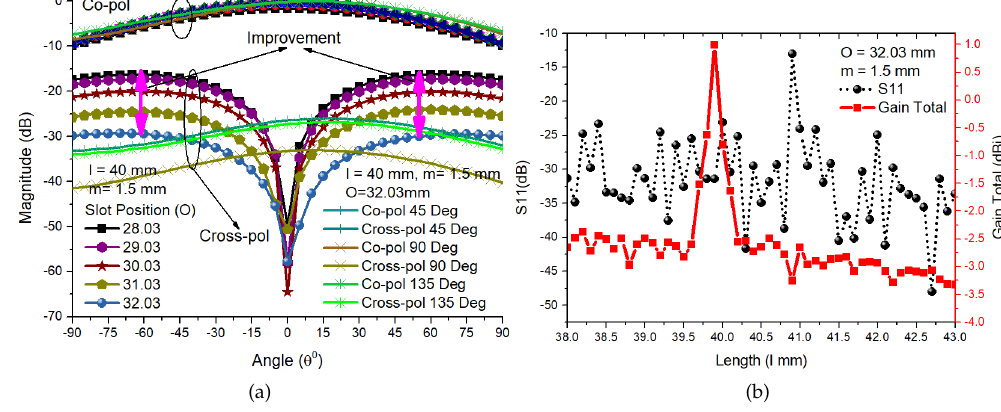
Figure 4. Parametric analysis at 2.2 GHz ( a ) Position of the slot (O) versus co and cross-polarization, φ = 0 ◦ ( b ) Slot length (l) versus S11 and gain